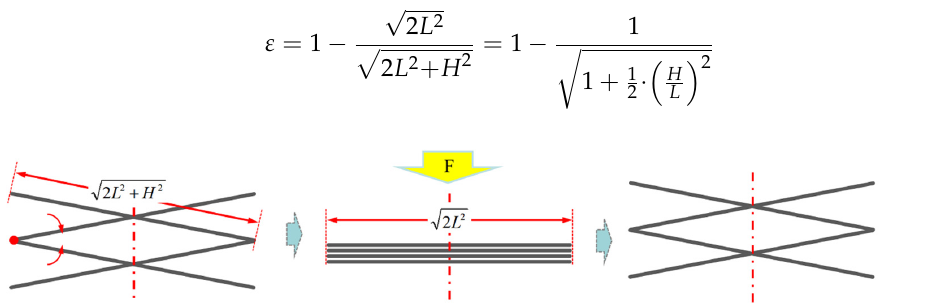
Figure 9. Force analysis of rods.